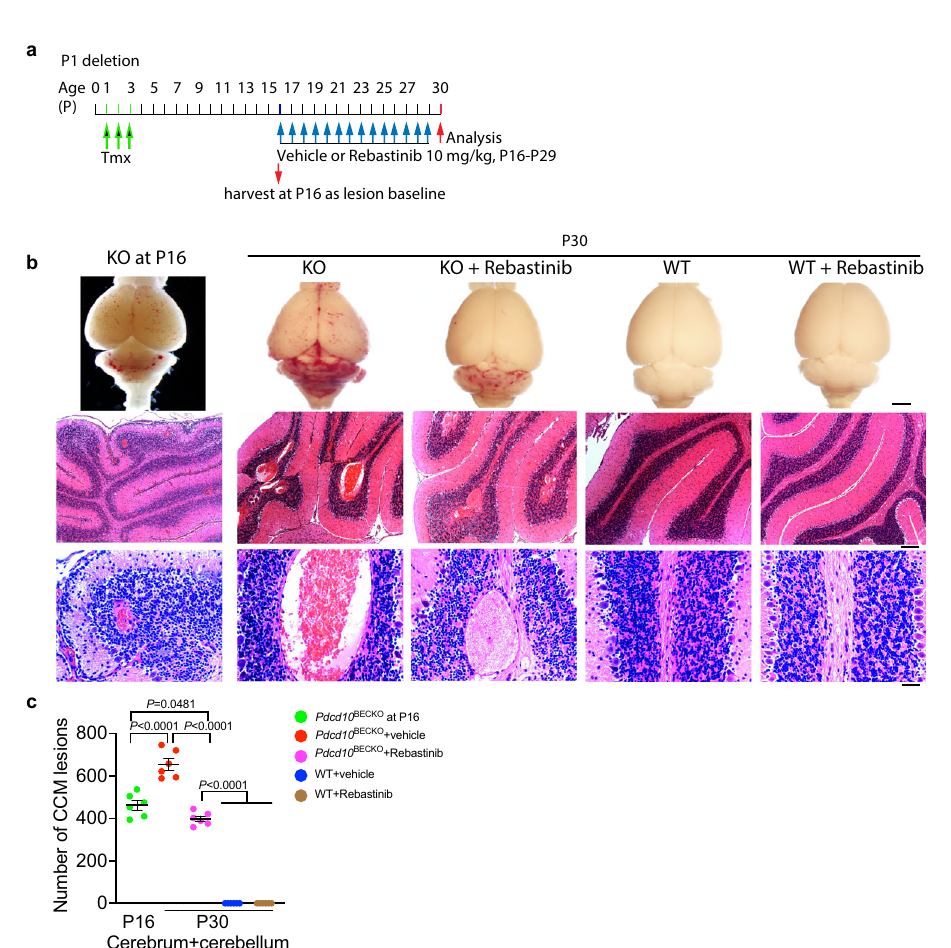
Fig. 9 Tie2 inhibition prevents progression of pre-existing lesions. a A diagram for the protocol. WT and P1 deletion Pdcd10 BECKO mice were subcutaneously administrated with vehicle or Rebastinib daily at P16 – P29 and brain tissues were harvested at P30. P16 KO mice were harvested as lesion baselines. b Images of fresh brain tissue and H&E staining of brain sections. c The numbers of total lesions were quanti fi ed as # of lesions per 10 coronal sections, which were 200 μ m apart. n = 6 mice per group. P values are indicated, one-way ANOVA followed by Sidak ’ s multiple comparisons test. Data are means ± SEM. Scale bars: 1 mm ( b top panel); 100 μ m ( b middle panel); 25 μ m ( b bottom panel). Source data are provided as a Source data fi primary antibodies were diluted 1:1000. For data presented in the same fi gure antibody against CCM3 was generated (Invitrogen) against full-length recombinant panel, the samples were derived from the same experiment and that gels/blots were human CCM3 protein expressed and puri fi ed from Escherichia coli . β -actin processed in parallel. Uncropped blots and gel images were provided in the Source (mouse, A1978) and β -actin (mouse, A5441) were from Sigma; p-Caveolin-1 data fi le. (rabbit, 611339) was from BD Pharmingen; Abl (rabbit, 2862s), p-Akt (rabbit, 9271), Akt (rabbit, 9272), p-MLC2 (rabbit, 3674), PDGFR- β (rabbit, 3168), p-Tie2 (rabbit, 4221), p-Tie2 (rabbit, 4226), Tie2 (rabbit, 4224), and VEGFR2 (rabbit, Gene expression . Total RNA was isolated from tissues or cells using the RNeasy 2479) were from Cell Signaling Technology. Caveolin-1 (rabbit, sc894) was from kit with DNase I digestion (Qiagen, Valencia, CA). Reverse transcription was Santa Cruz. Angpt2 (rabbit, ab8452), p-Abl (rabbit, ab4717), and N-Cadherin performed using standard procedures (Super Script fi rst-strand synthesis system; (rabbit, ab76057) were from Abcam; Angpt2 (AF7186) was from R&D Systems. All